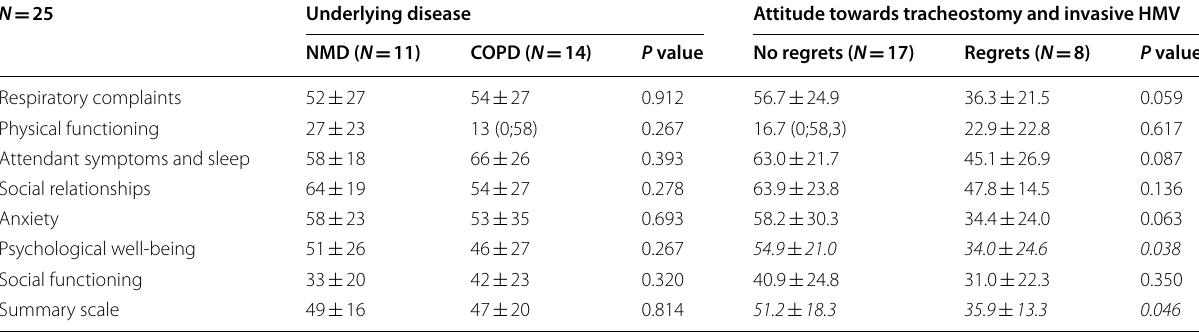
Table 1 Sub- and summary scales of the SRI according to underlying disease (NMD vs. COPD) and individual attitudes towards tracheostomy and invasive